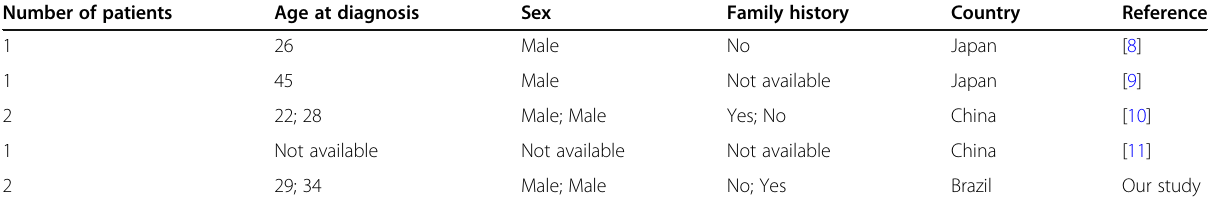
Table 2 Reported cases of Lipoprotein Glomerulopathy associated with the Osaka/Kurashiki APOE variant Number of